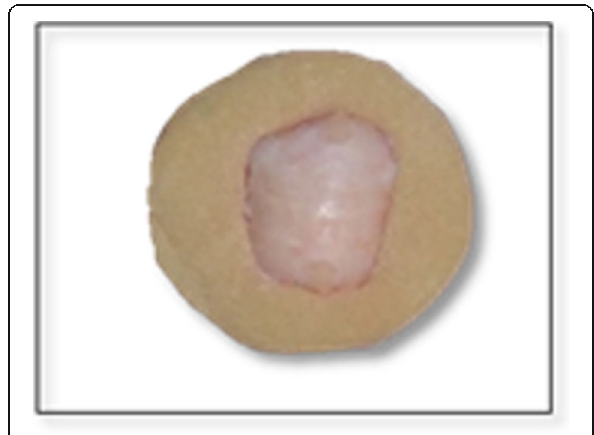
Fig. 1 Tooth embedded in acrylic resin with the buccal surface parallel with the base